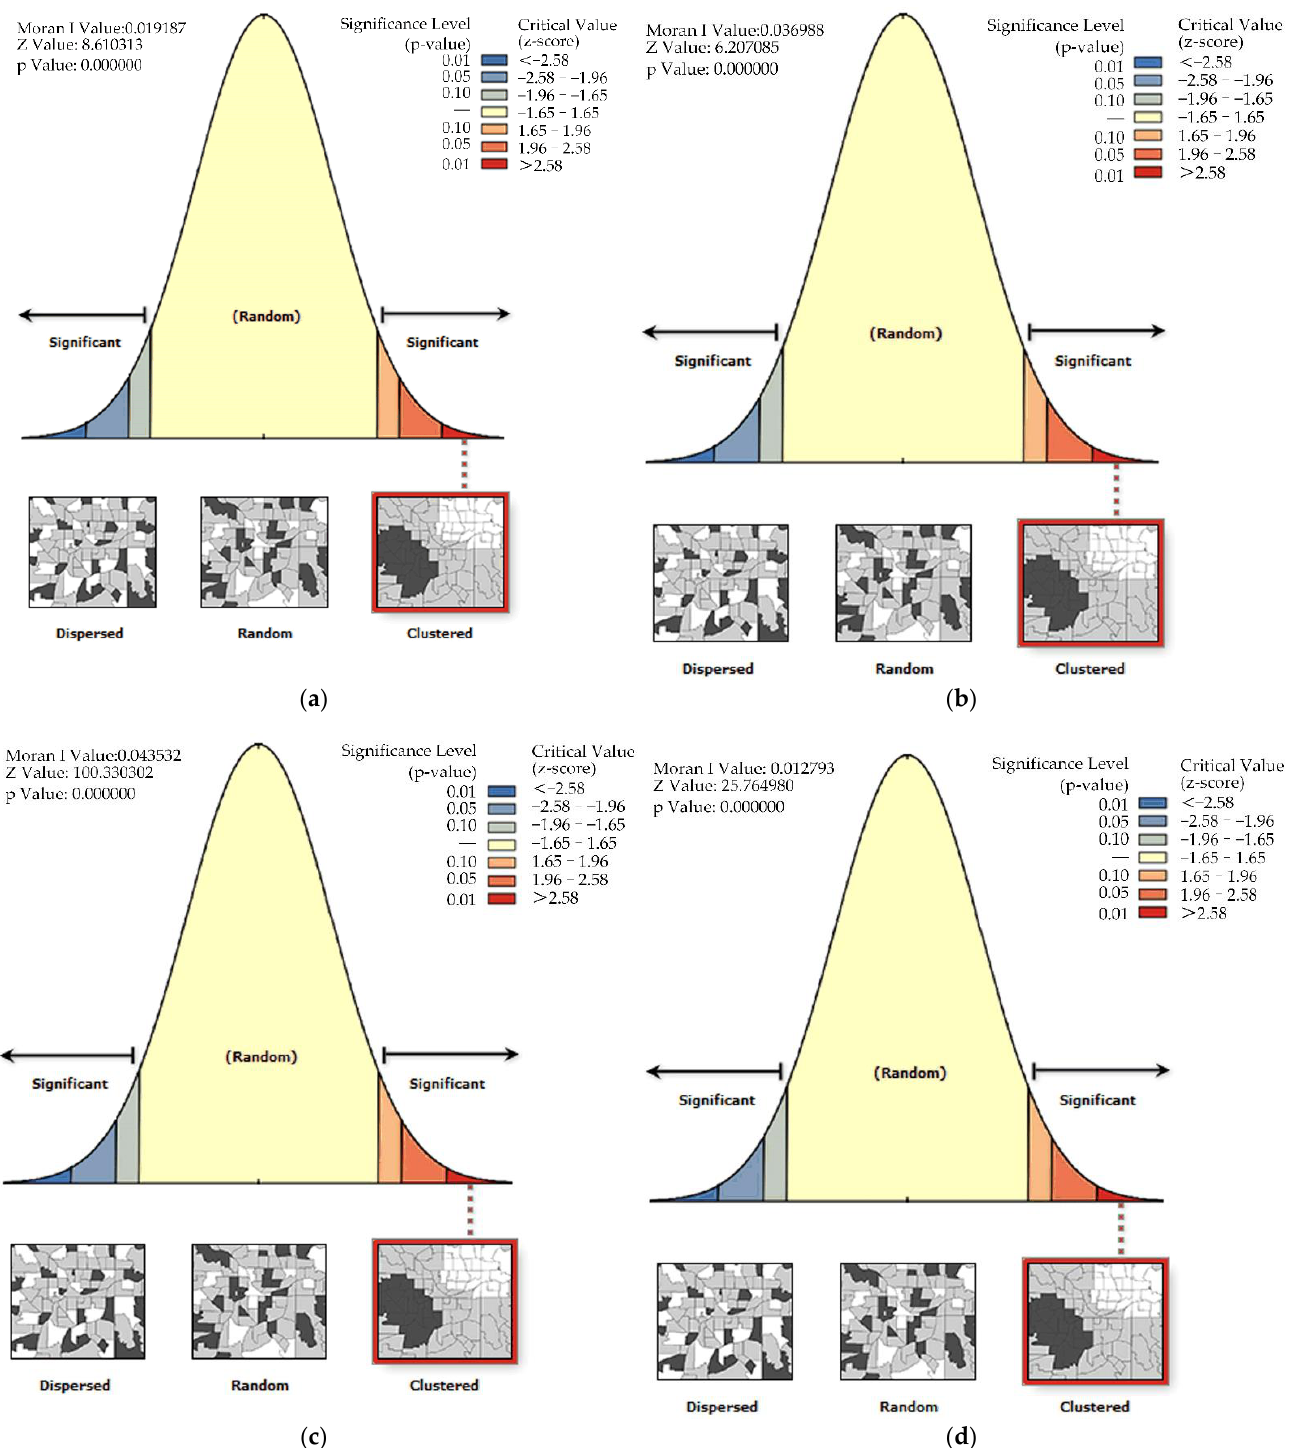
Figure 8. Spatial autocorrelation analysis results of PWD distribution in different years (( a – d ) are 2000, 2010, 2020 and 2030, respectively).